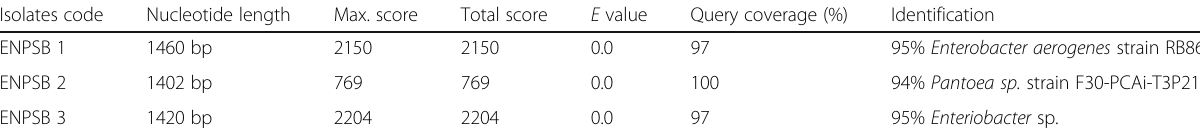
Table 2 Similarity of 16S rRNA sequences for the selected strains compared to those obtained from database Isolates code